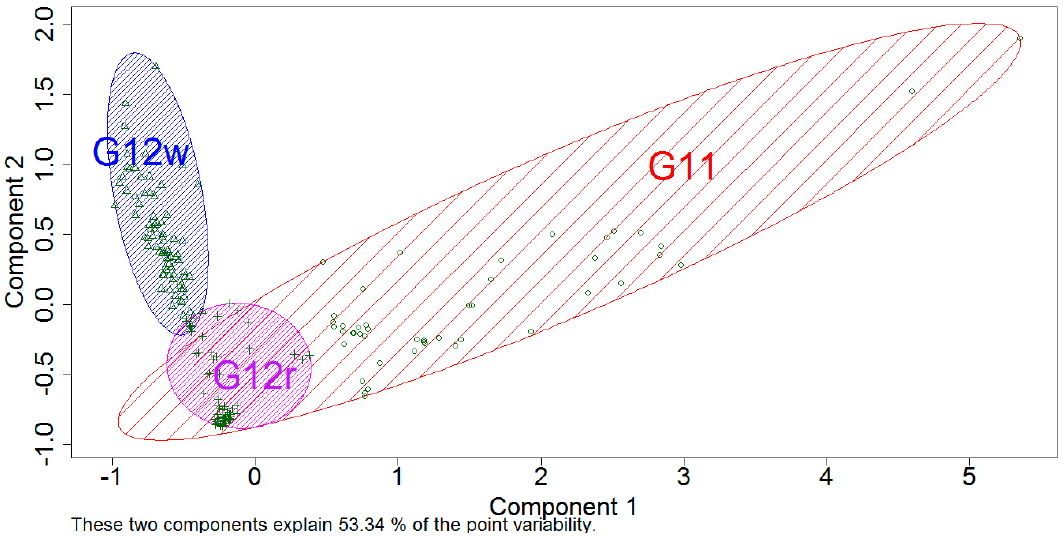
Figure 11. Multidimensional scaling (MDS) surface for grouping the entities based on their usage